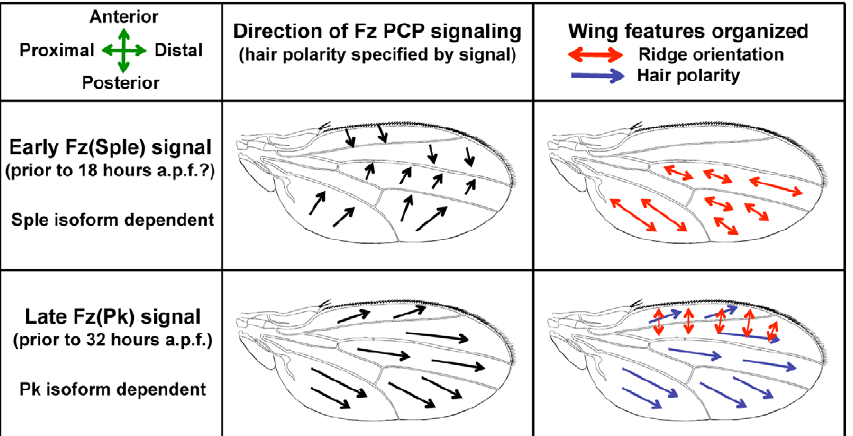
Figure 1. A Bidirectional-Biphasic (Bid-Bip) model for Fz PCP signaling in the Drosophila wing. The model proposes two distinct Fz PCP signals that differ both in direction and in use of the Prickle protein isoforms, Pk and Sple. An Early Fz(Sple) signal along the A-P axis organizes posterior ridge orientation. A Late Fz(Pk) signal along the P-D axis organizes anterior ridge orientation and hair polarity. (a.p.f.=after pupal